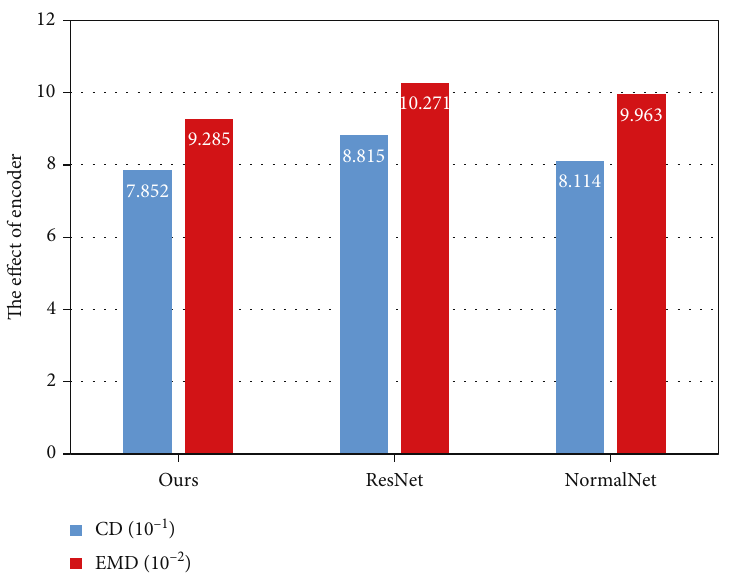
Figure 5: The e ff ect of di ff erent encoder structure.